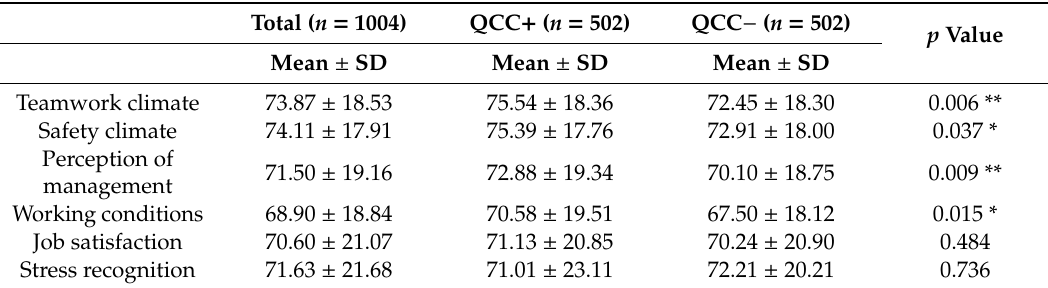
Table 2. Scores of safety attitudes questionnaire (SAQ) subscales between participants with or without